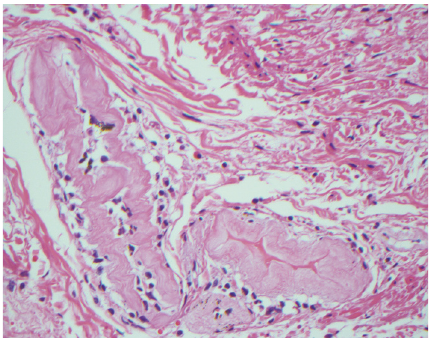
Figure 2: Pulse granuloma with characteristic dense and eosinophi- lic hyaline rings within the wall of the gallbladder (H&E, original magnification ×